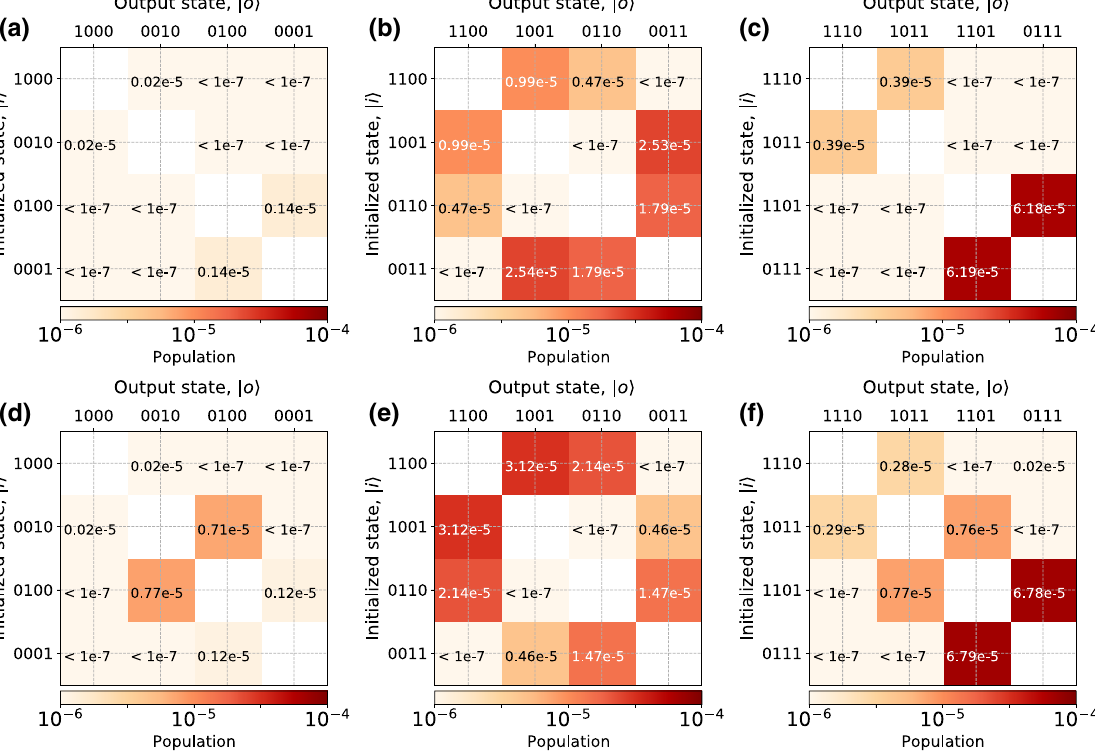
FIG. 15. Population swap matrix P ( o | i ) for the implementation of simultaneous CZ gates in the four-qubit square system shown in Fig. 5(c). The matrix element P ( o | i ) denotes the population in state | o (cid:2) for the qubit system initialized in state | i (cid:2) . [(a),(d)] for the qubit system initialized in the single-excitation subspace {| 1000 (cid:2) , | 0010 (cid:2) , | 0100 (cid:2) , | 0001 (cid:2)} , [(b),(e)] for the two-excitation subspace {| 1100 (cid:2) , | 1001 (cid:2) , | 0110 (cid:2) , | 0011 (cid:2)} , and [(c),(f)] for the three-excitation subspace {| 1110 (cid:2) , | 1011 (cid:2) , | 1101 (cid:2) , | 0111 (cid:2)} . (a)–(c) Population swap matrix for the parallel implementation of CZ 01 and CZ 23 . (d)–(f) Population swap matrix for the parallel implementation of CZ 12 and CZ 30